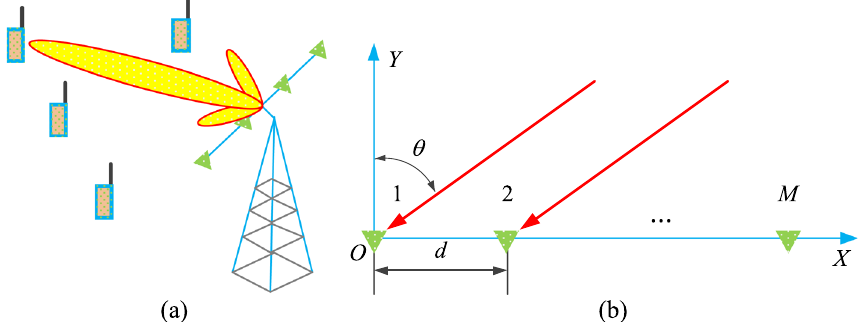
Fig. 1 Signal model. a Classical application of adaptive beamforming in wireless communication, with the mainlobe pointing toward the user. b ULA